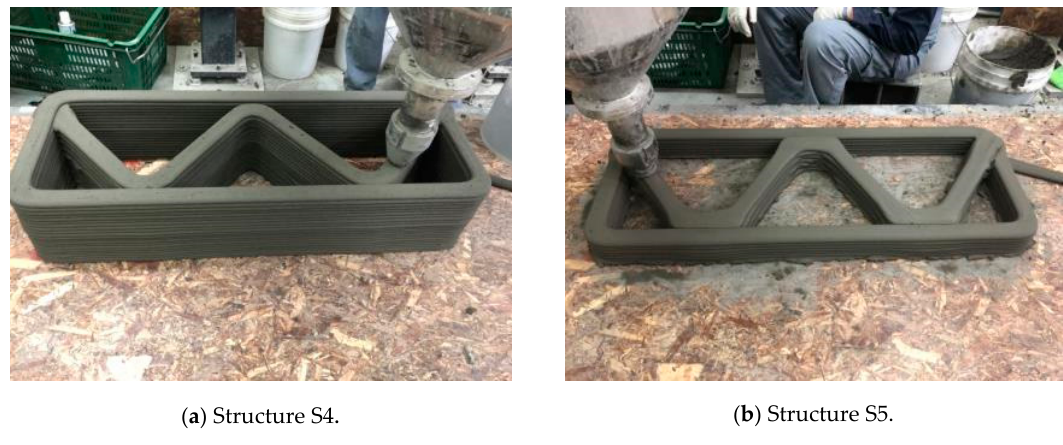
Figure 2. Printing of structures S4 and S5.